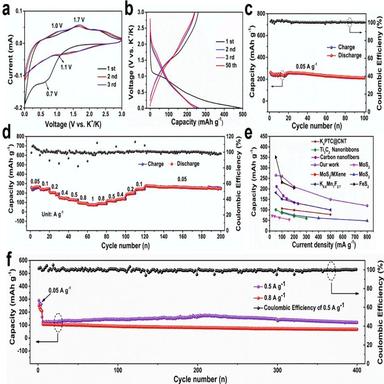
Electrochemical performances of 1 T-MoS2/MoOx@NC for PIBs: (a) CV curves, (b) galvanostatic discharge–charge profiles for different cycles at a current density of 0.05 A g− 1 , (c) cycling performance at 0.05 A g− 1 , (d) rate capability at different current densities, (e) rate performance comparison with previously reported anodes for PIBs, and (f) cycling performances at high current densities of 0.5 and 0.8 A g− 1 .